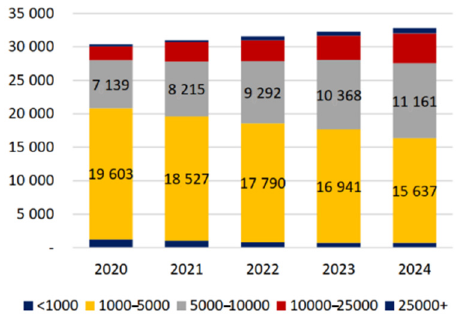
Figure 2. Increasing trend of households with income above 5000 USD.